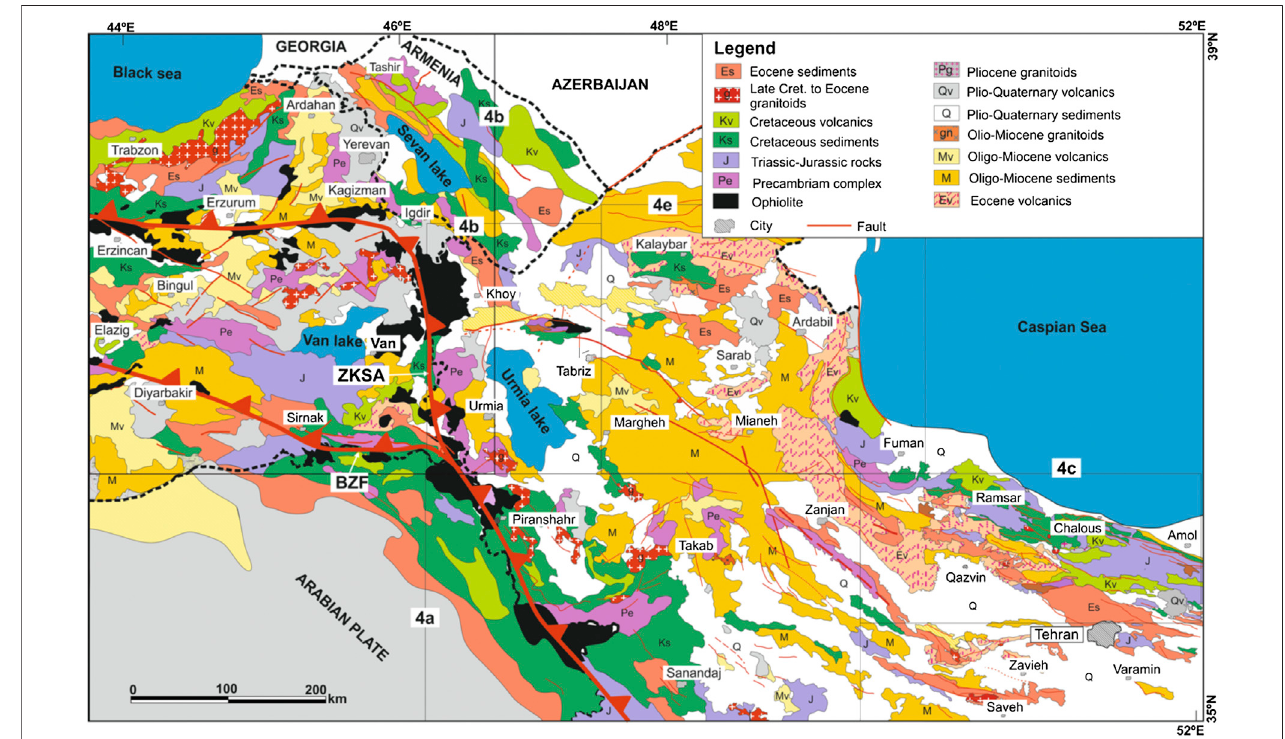
FIGURE 3 | Simpli fi ed geology units between the Black and Caspian seas that show the main sutures, ophiolites, and magmatic rocks in more detail. See the Supplementary S1 for the references. Rectangles show the locations of the detailed geological maps in Figure 4(A – E) and the location of the study area examined by